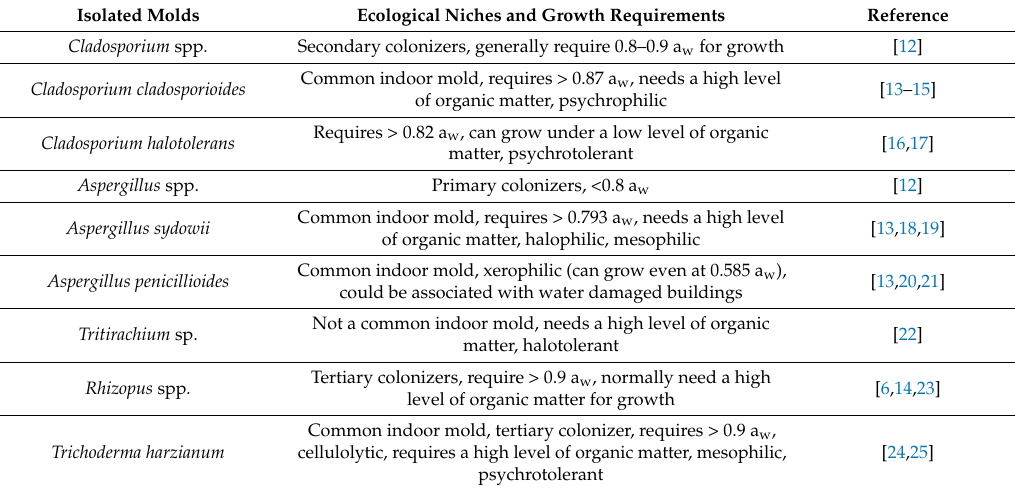
Table 3. Ecological niches and growth requirements of the isolated